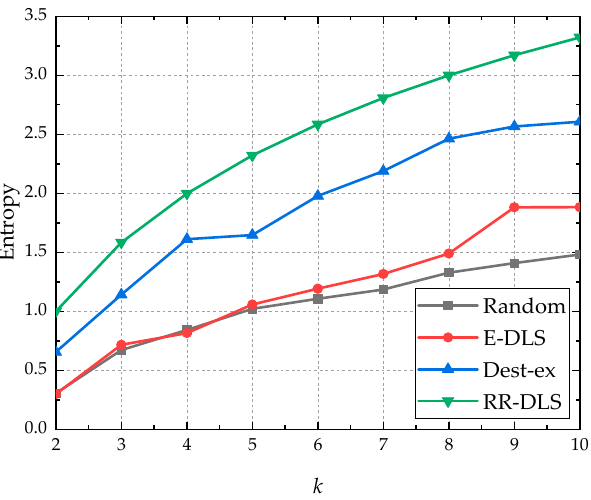
Figure 8. Anonymous entropy of different dummy location selections algorithms.